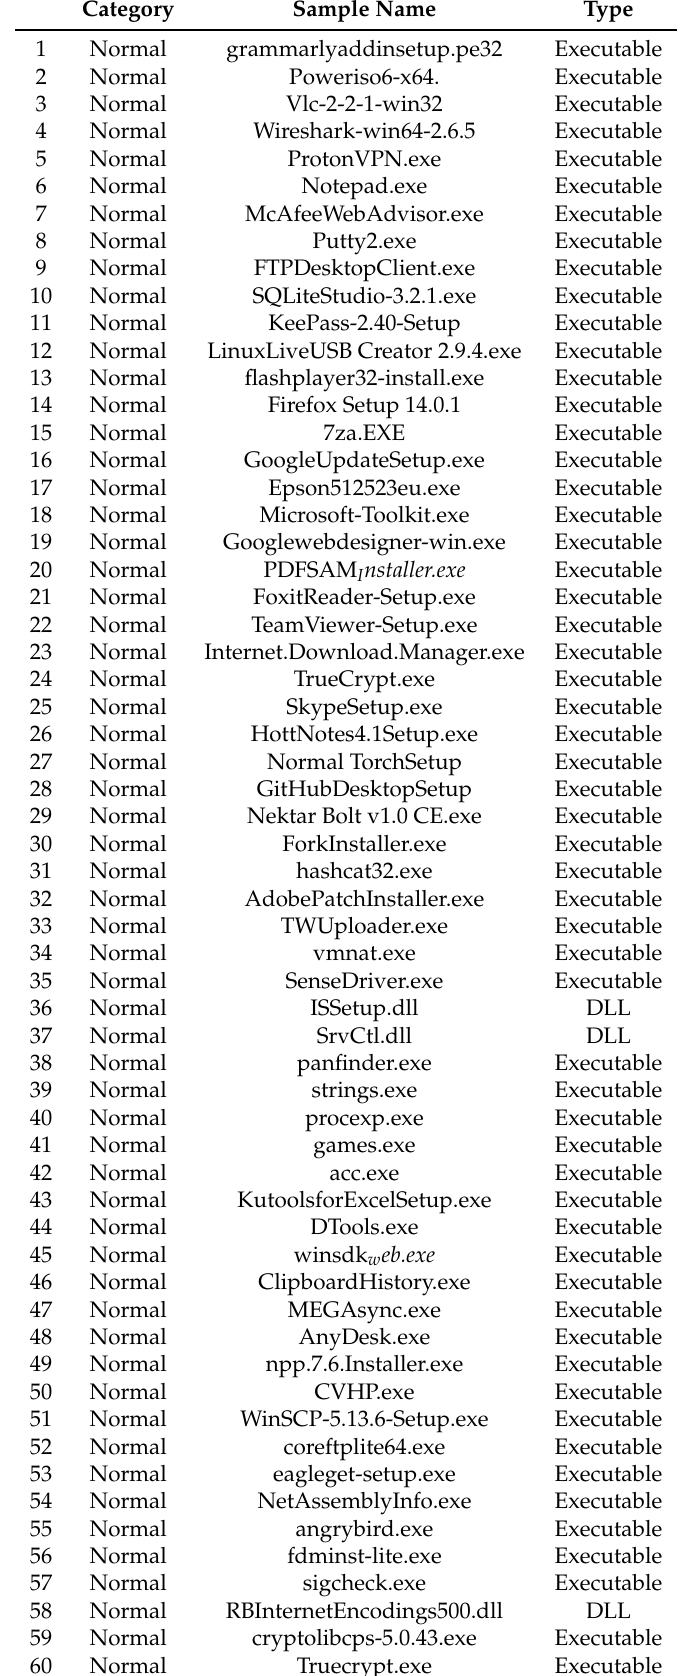
Table 6. Clean samples that were